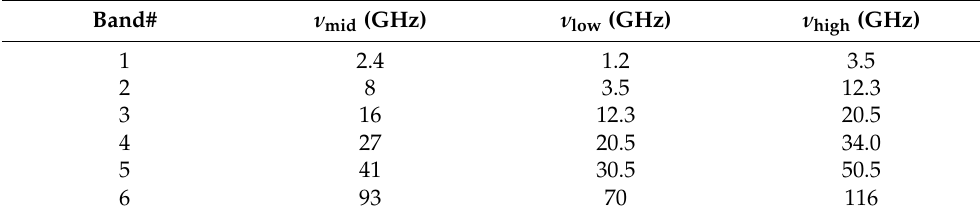
Table 1. The current ngVLA receiver configuration.